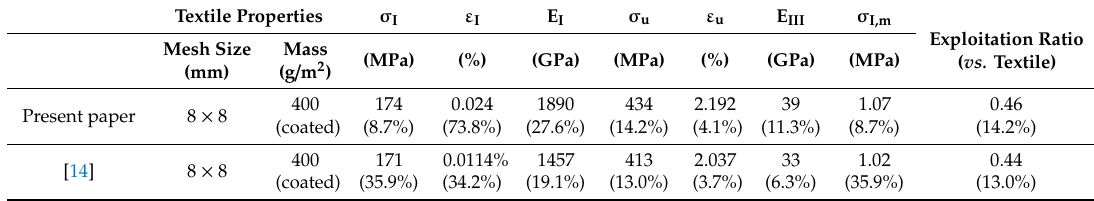
Table 5. Tensile tests results: FRAAM composite and commercial system